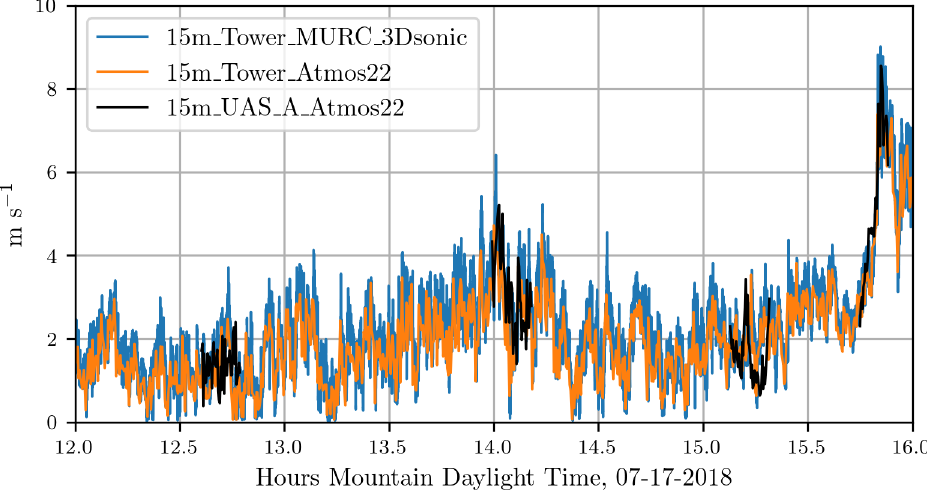
Figure 9. Comparison of wind speed measurements from UAS A and ground-based sensors.